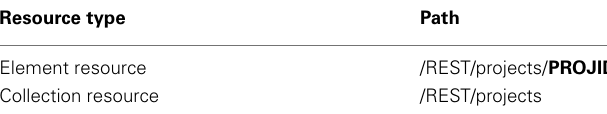
Table 1 | XNAT URI design.